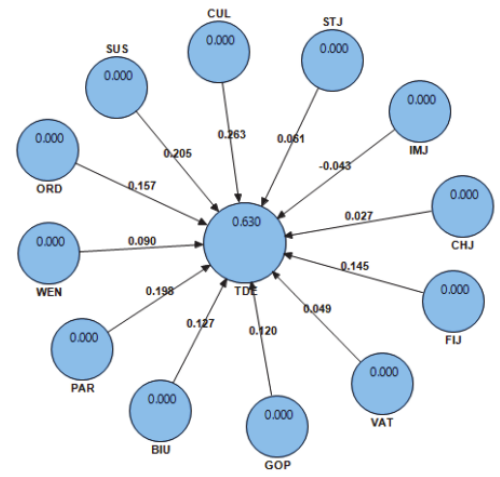
Fig. 4. T-Student test results for examining the significance of the path